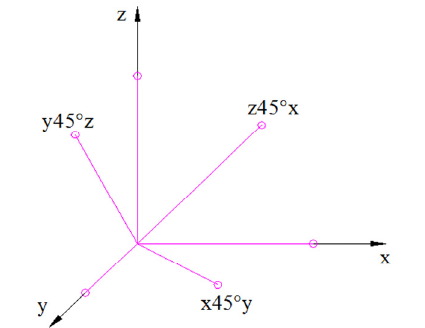
Figure 5. Boreholes layout for the rock core.